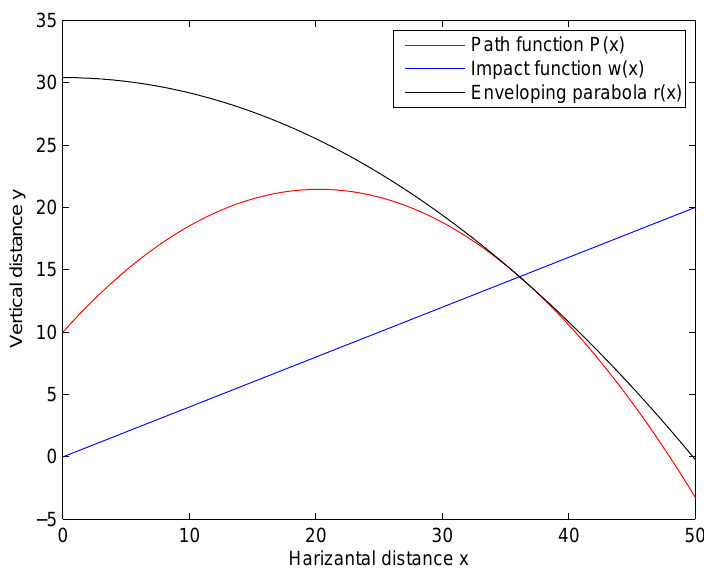
Figure 1. The enveloping parabola with linear impact